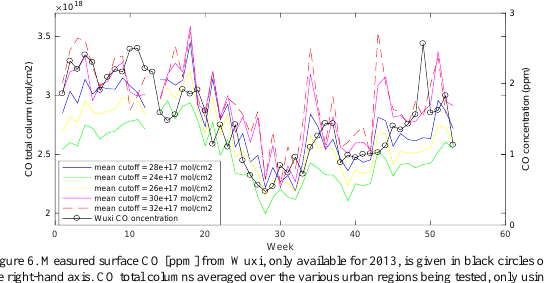
Figure 6. Measured surface CO [ppm] from Wuxi, only available for 2013, is given in black circles on the right-hand axis. CO total columns averaged over the various urban regions being tested, only using data from 2013, are given on the left-hand axis, where the [red dashes] is the 32  10 17 mol / cm 2 cutoff, the [magenta line] is the 30  10 17 mol / cm 2 cutoff, the [blue line] is the 28  10 17 mol / cm 2 cutoff, and the [green line] is the 24  10 17 mol / cm 2 cutoff. In all cases, a standard deviation cutoff of 6.0  10 17 mol / cm 2 was applied.